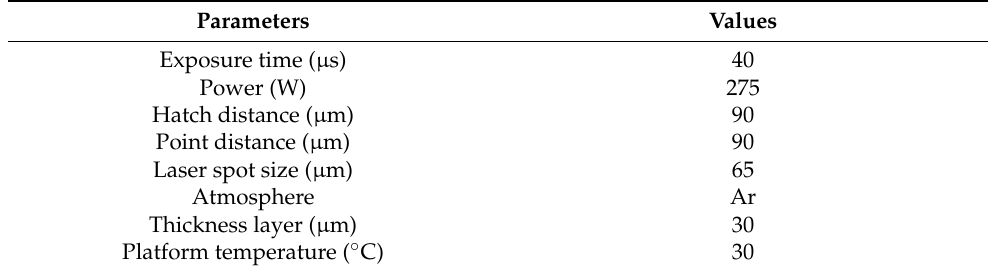
Table 2. Used LPBF processing parameters.